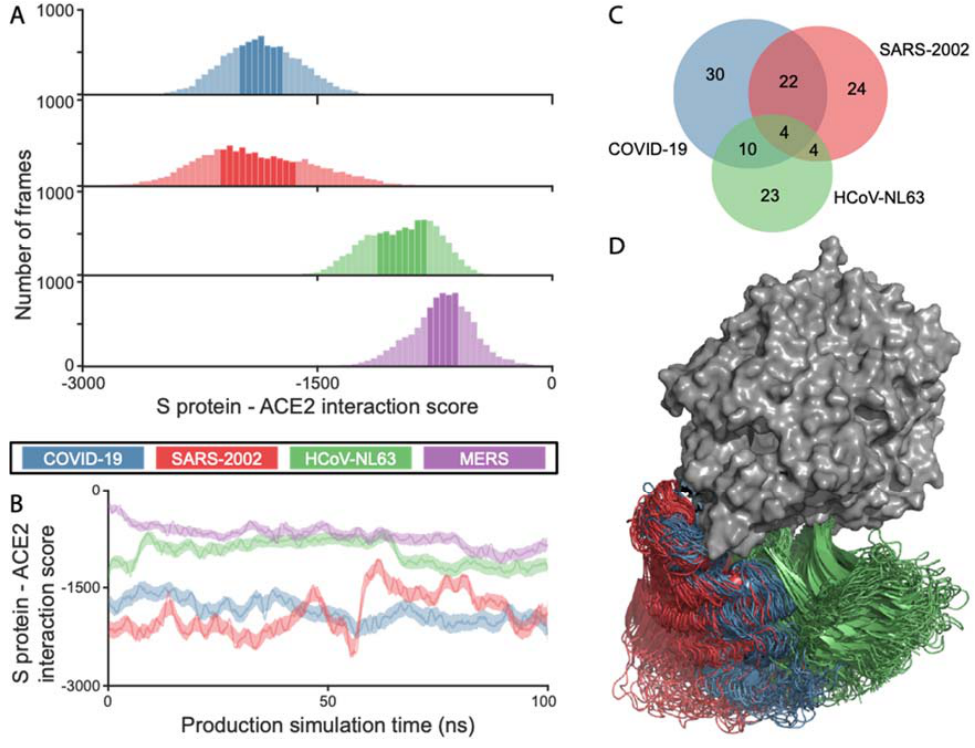
Figure 1. Analysis of RBD–ACE2 interactions based on the molecular dynamics (MD) trajectories. COVID-19, SARS-2002, HCoV-NL63, and MERS are colored blue, red, green, and purple, respectively. ( A ) Histograms of the RBD–ACE2 interaction scores throughout the simulation trajectory. Darker color represents 75% of all frames; ( B ) the score values along the simulation trajectory, smoothed along the elapsed time; ( C ) Venn diagram of ACE2 interacting residues for COVID-19, SARS-2002, and HCoV-NL63. An ACE2 residue is considered as part of the interface if one of its atoms is within 4 Å from any RBD atom in at least 10% of the 10,000 MD simulation frames; ( D ) overlay of 50 snapshots for each of the three RBDs. The ACE2 is in surface representation (gray). The frames were aligned using the N-terminal fragment of the ACE2 that contains the two helices participating in the RBDs binding.